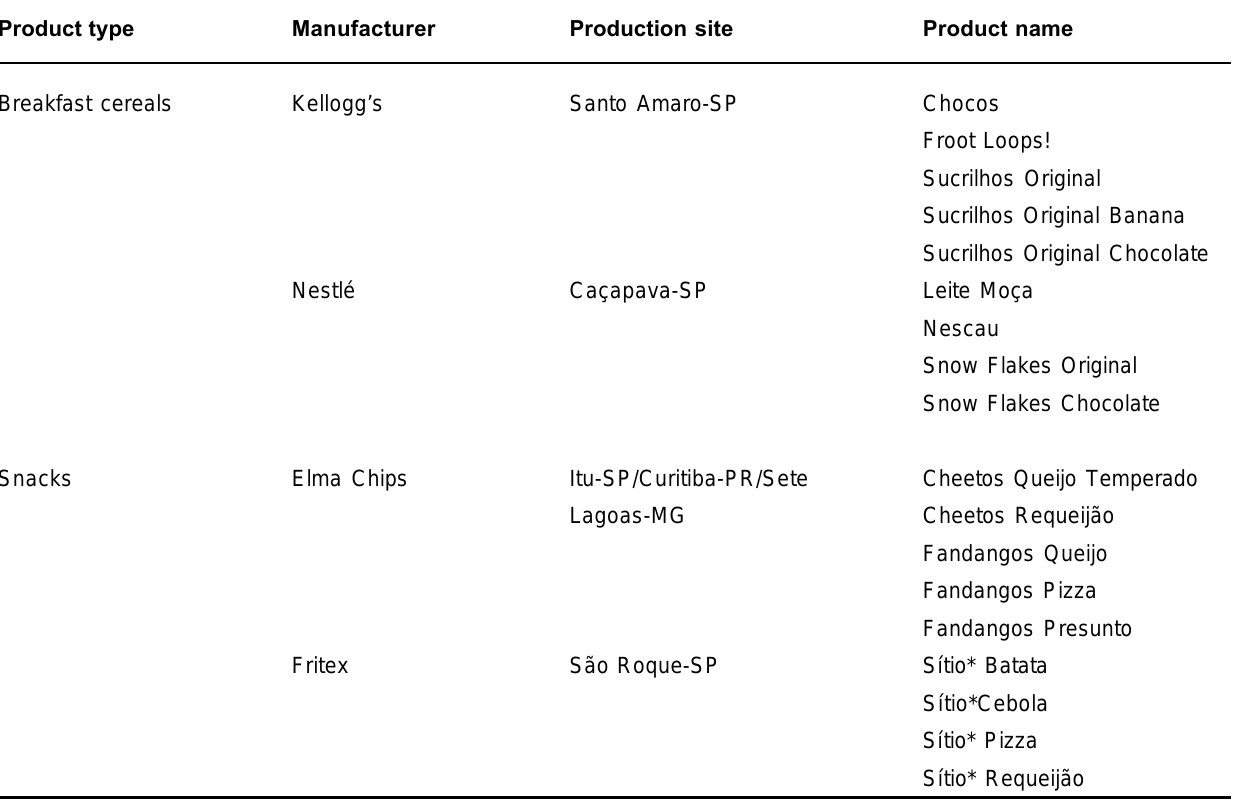
TABLE 1 - Breakfast cereals and snacks